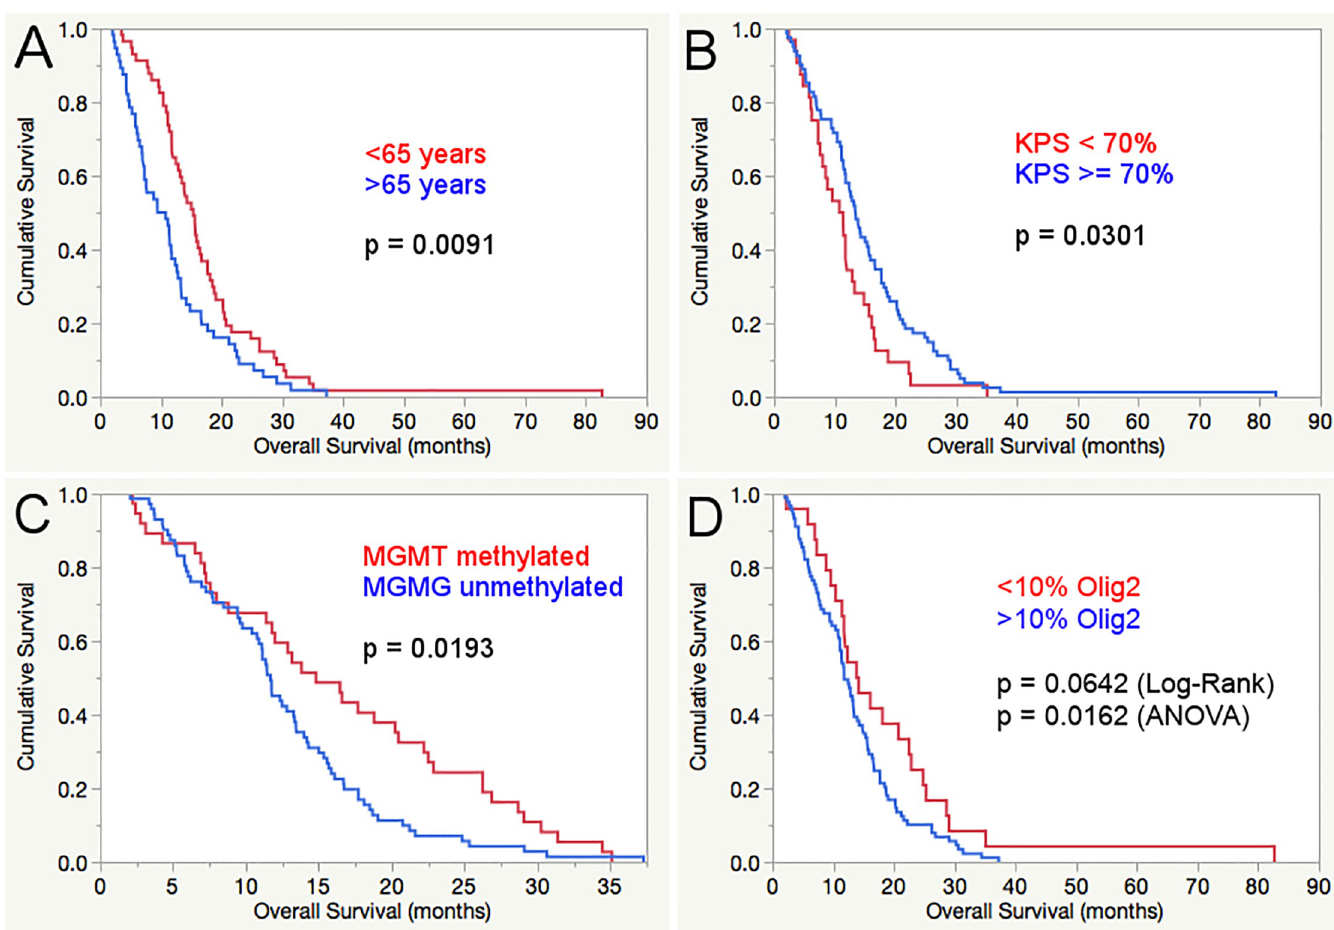
Fig 3. Kaplan-Meier curve and Log-rank test displaying the significant prognostic impact of age below 65 years (A), better clinical status (KPS > / = 70) (B) and methylated MGMT -promoter status (C) as well as a trend towards survival benefit of Olig2 expression below 10% in the Log-rank test and a significant difference in the ANOVA